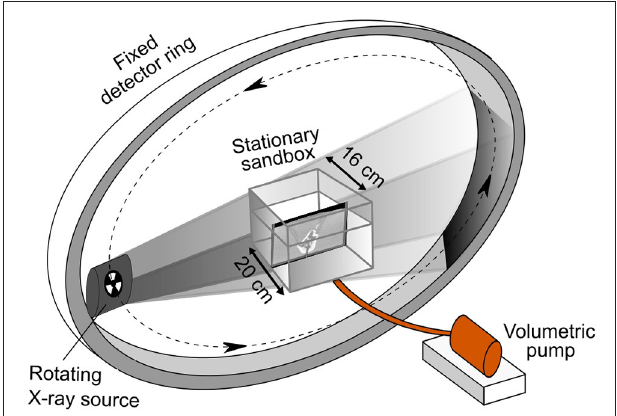
FIGURE 2 | Experimental set-up at the medical wide beam X-ray Computed Tomography scanner (GE Healthcare) of the UZ Brussel hospital, Belgium. The experimental box containing the compacted granular analog is in a fixed position—in the location of the “patient”—and is connected by a flexible tube to a computer-controlled constant-rate volumetric syringe pump containing the magma analog golden syrup. During syrup injection, a 3D CT image is obtained every 20s over an acquisition time of 1s by rotating an X-ray source within a fixed 16cm wide X-ray detector ring.